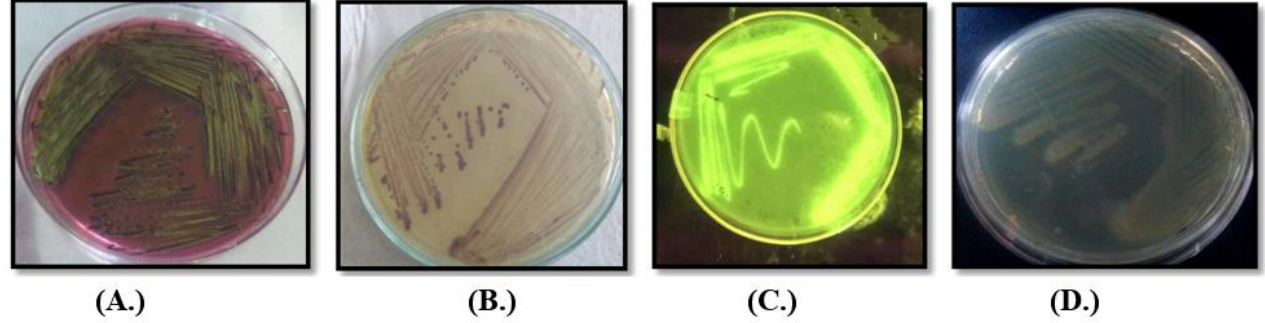
Figure 3. Colony morphology of different microbes on different media ( A .) E. coli on EMB ( B .) Klebsiella on Klebsiella selective agar and ( C .) Pseudomonas sp. on Kings B medium under UV transilluminator and ( D .) Proteus sp. on nutrient agar.